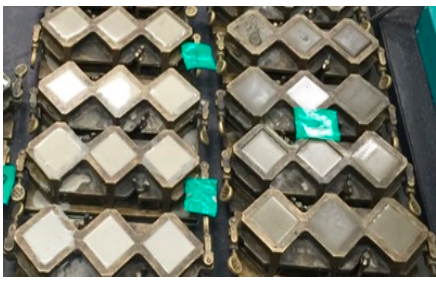
Figure 3. Specimens for homogel compressive-strength test.